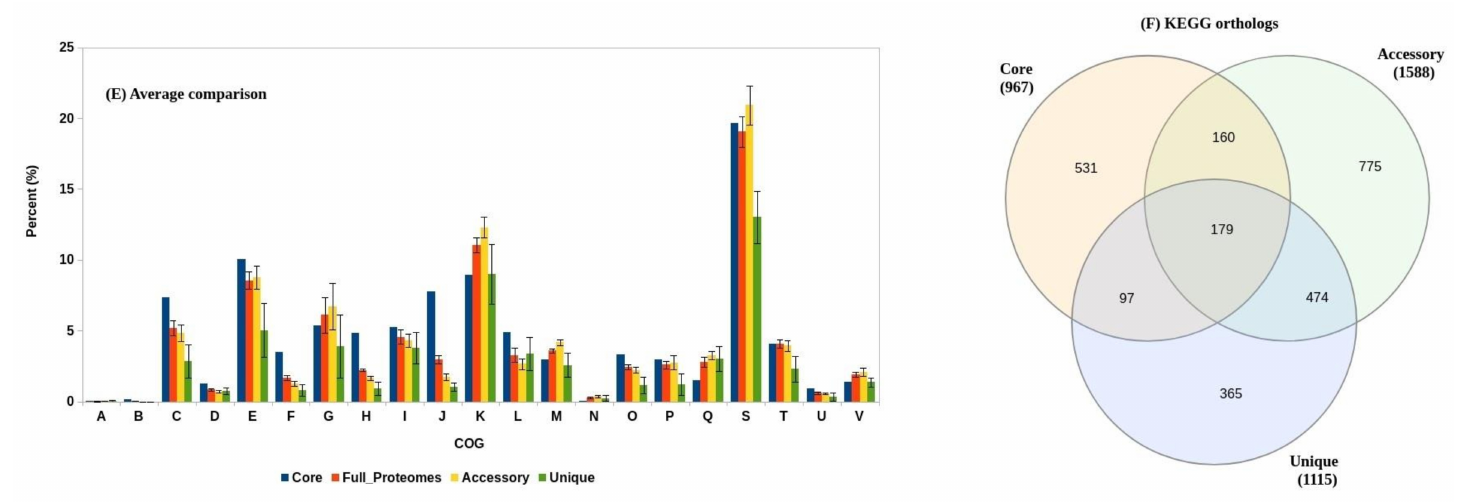
Figure 2. Distribution of COG categories in Streptacidiphilus genomes. ( A ) Full proteomes of Streptacidiphilus species, and for additional comparison representative strains from Kitasatospora and Streptomyces are added. ( B ) Core genome, ( C ) accessory genome, ( D ) unique genome, ( E ) average comparison, and ( F ) KEGG orthologs. The COG categories indicate RNA processing and modification (A), chromatin structure and dynamics (B), energy production and conversion (C), cell cycle control, cell division, chromosome partitioning (D), amino acid metabolism and transport (E), nucleotide metabolism and transport (F), carbohydrate metabolism and transport (G), coenzyme metabolism and transport (H), lipid metabolism and transport (I), translation, ribosomal structure and biogenesis (J), transcription (K), replication, recombination and repair (L), cell wall / membrane / envelop biogenesis (M), post-translational modification, protein turnover, chaperone functions (O), inorganic ion transport and metabolism (P), secondary metabolites biosynthesis, transport and catabolism (Q), function unknown (S), signal transduction mechanisms (T), intracellular tra ffi cking, secretion, and vesicular transport (U), and defense mechanisms (V),